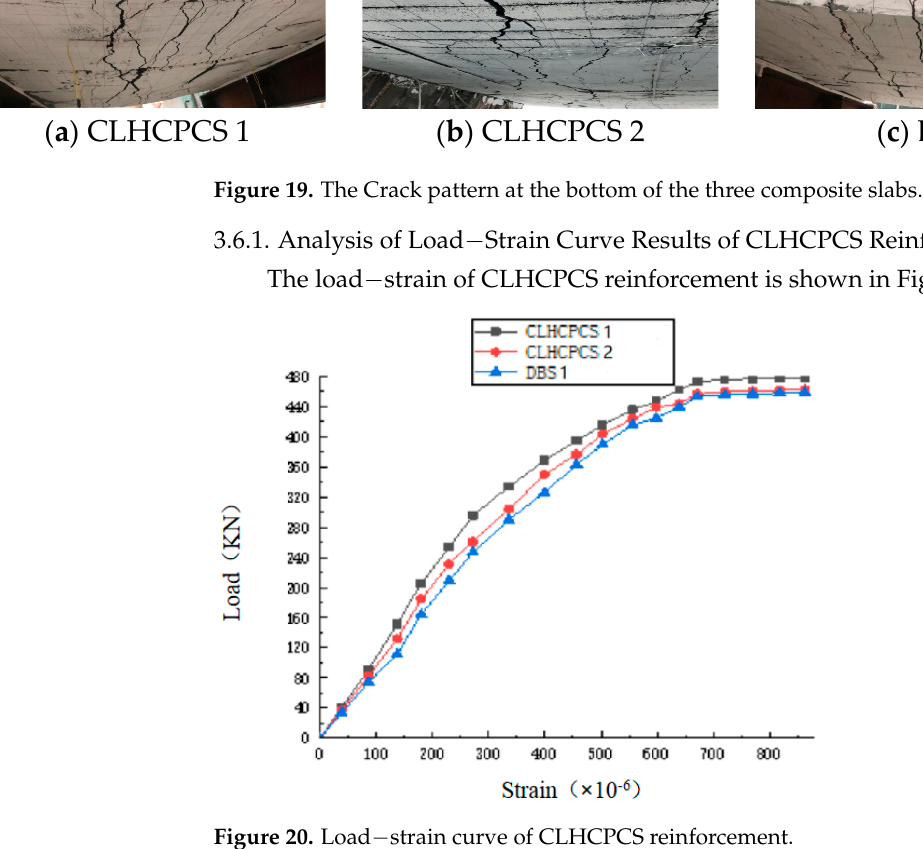
Figure 18. Comparison of crack distribution when CLHCPCS and ordinary concrete composite slab fail.